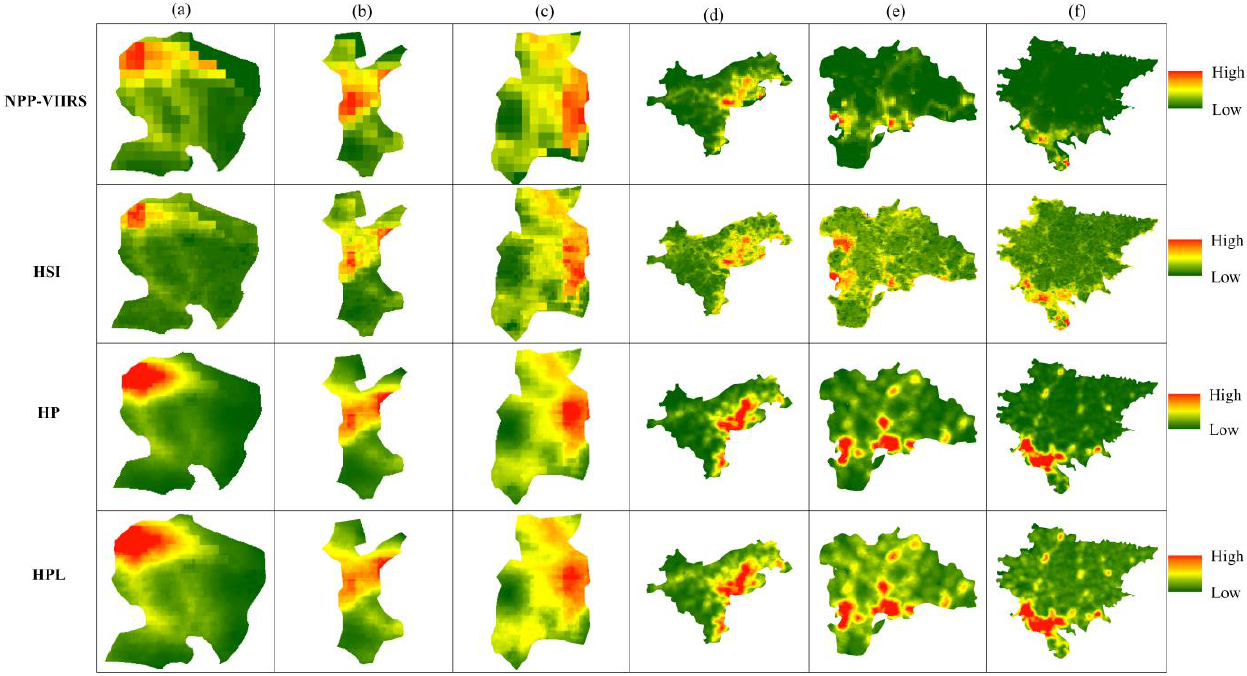
Figure 6. Spatial distribution images of NPP-VIIRS, HSI, HP, and HPL in selected areas of the six districts in Dalian: ( a ) Zhongshan District; ( b ) Xigang District; ( c ) Shahekou District; ( d ) Ganjingzi District; ( e ) Lushunkou District; ( f ) Jinzhou District.